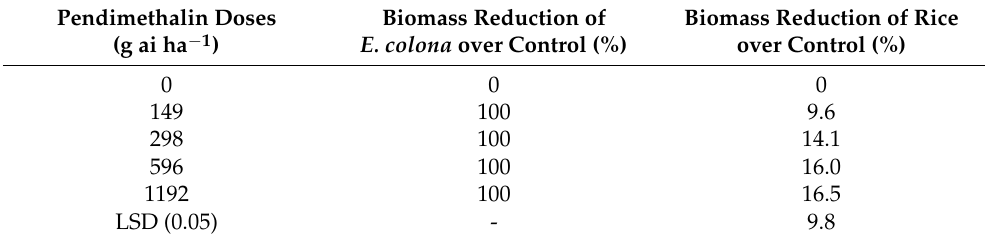
Table 5. Effect of pendimethalin on percent biomass reduction of Echinochloa colona control and rice.